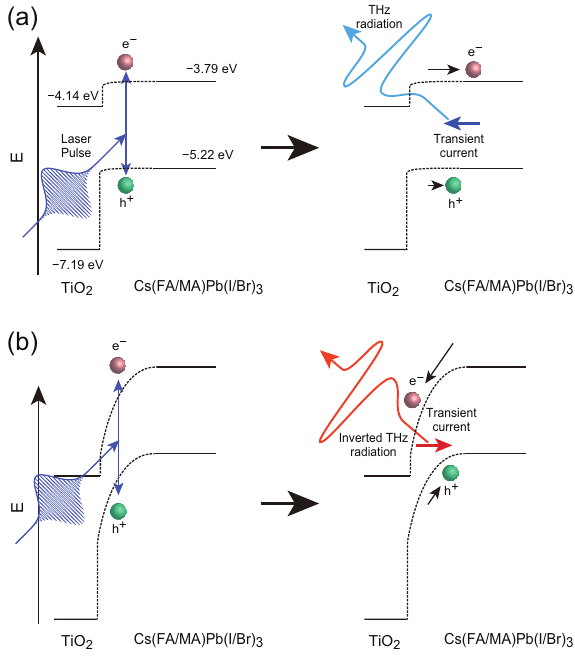
Figure 4. Qualitative illustration of a possible band diagram and dynamics of the photoexcited carriers to explain the reverse bias dependence of THz radiation. The illustrations correspond to the sample ( a ) without applied bias and ( b ) with reverse bias voltage greater than − 12